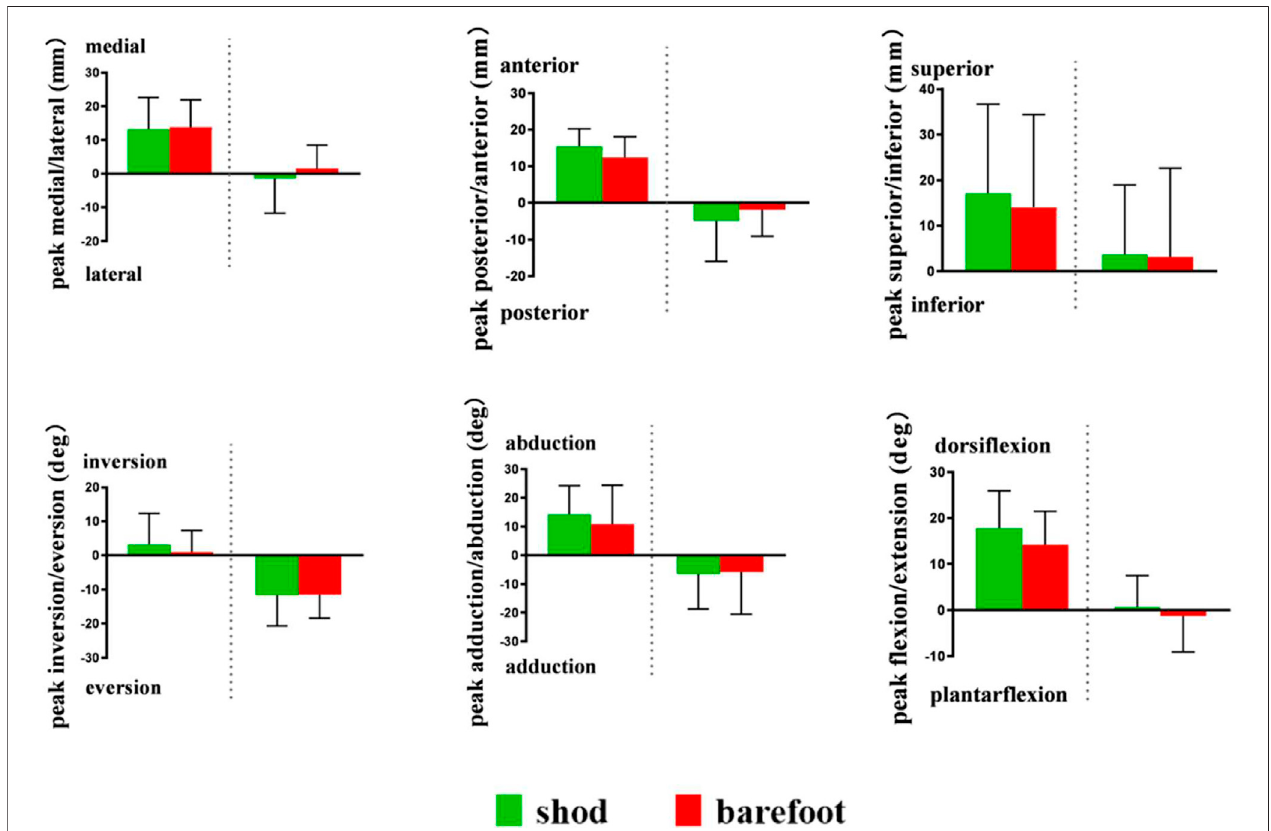
FIGURE7| Peaktranslationandrotationofthe fi rstmetatarsalrelativetocalcaneusinshodandbarefootconditions.*:signi fi cantdifferencesbetweentheshodand barefoot conditions, p < 0.05.